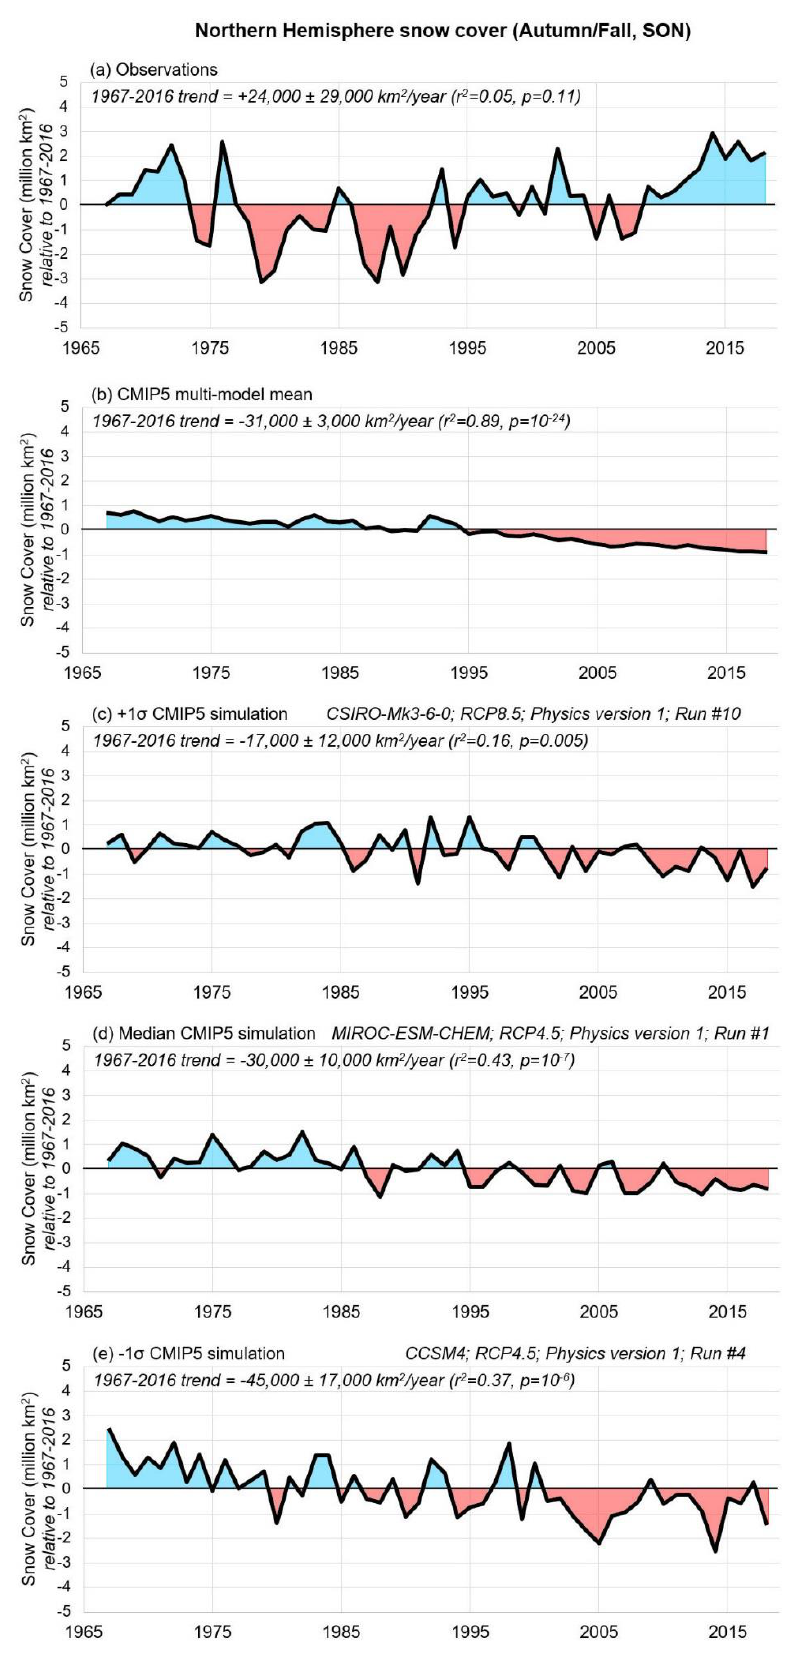
Figure 8. Same as Figure 4, except showing the autumn/fall (SON, i.e., September, October and November).